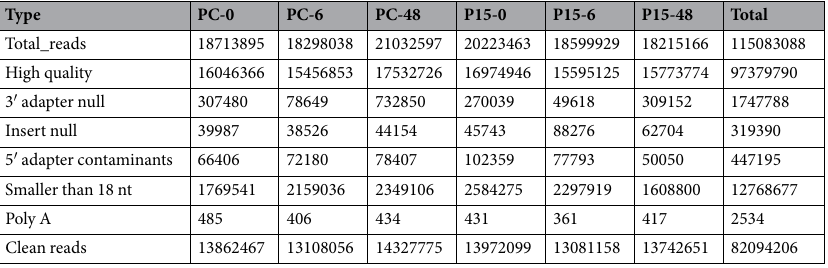
Table 1. Summary of small RNA sequences data.